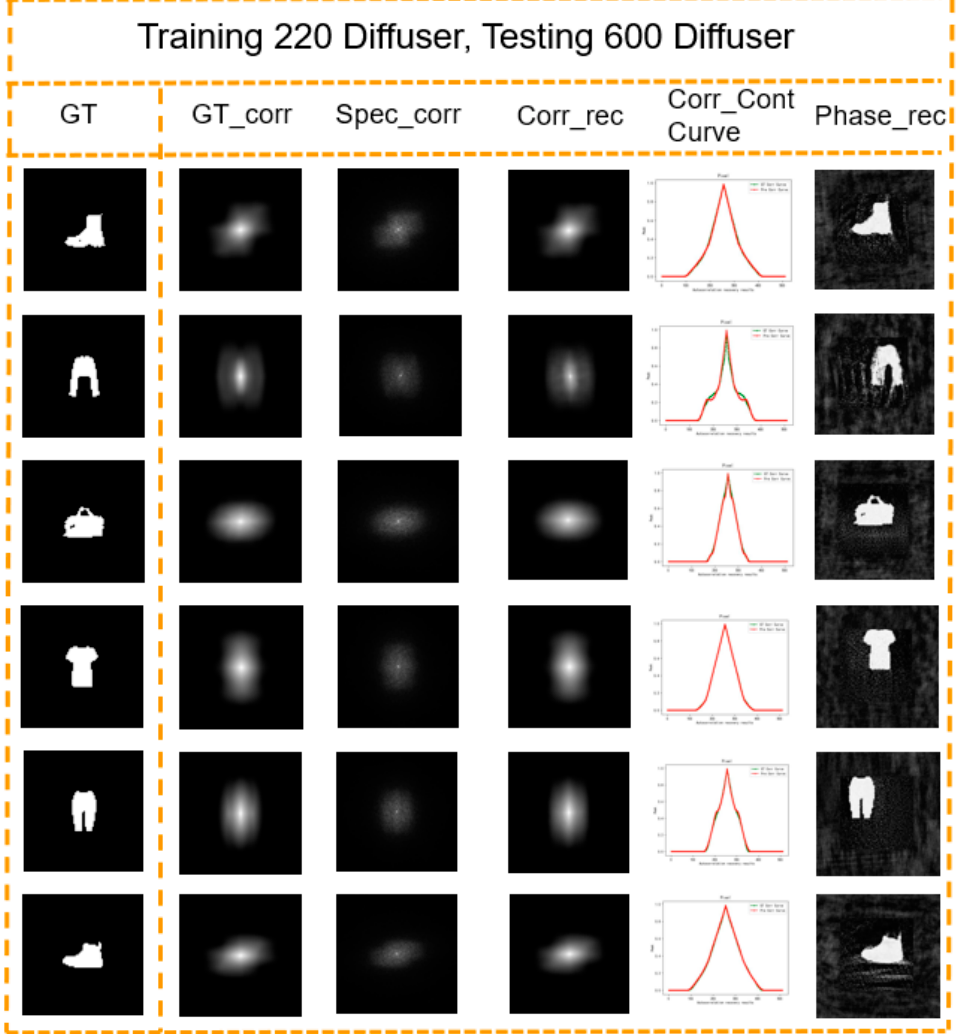
Figure 10. Results obtained using 220-mesh frosted-glass collection data as the training set and testing on 600-mesh frosted-glass collection data.